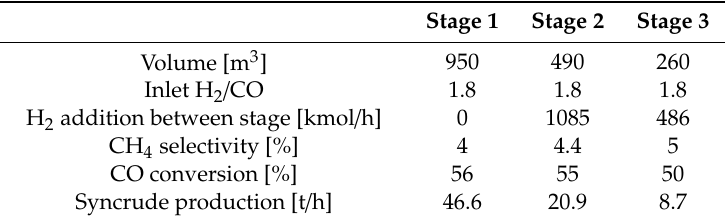
Table 2. Design parameters of di ff erent FT stages in biogas to liquid process.